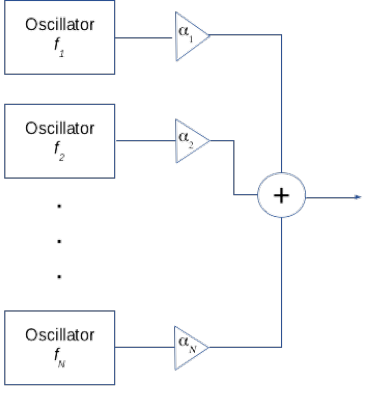
Figure 9. VLP schematic signal generation block